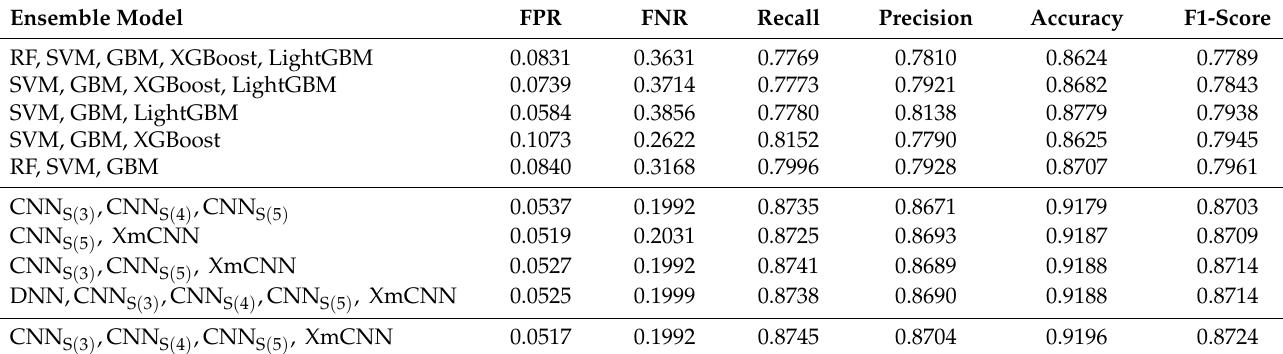
Table 9. Performance evaluation of ensemble